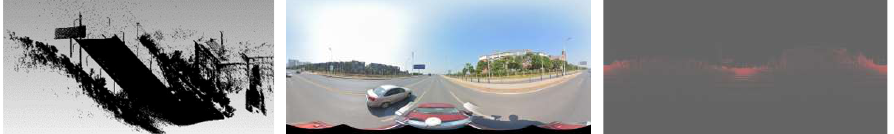
Figure 4. A virtual panoramic depth map ( right ) generated from 3D point cloud ( left ) using the same pose of the corresponding panoramic image ( middle ).